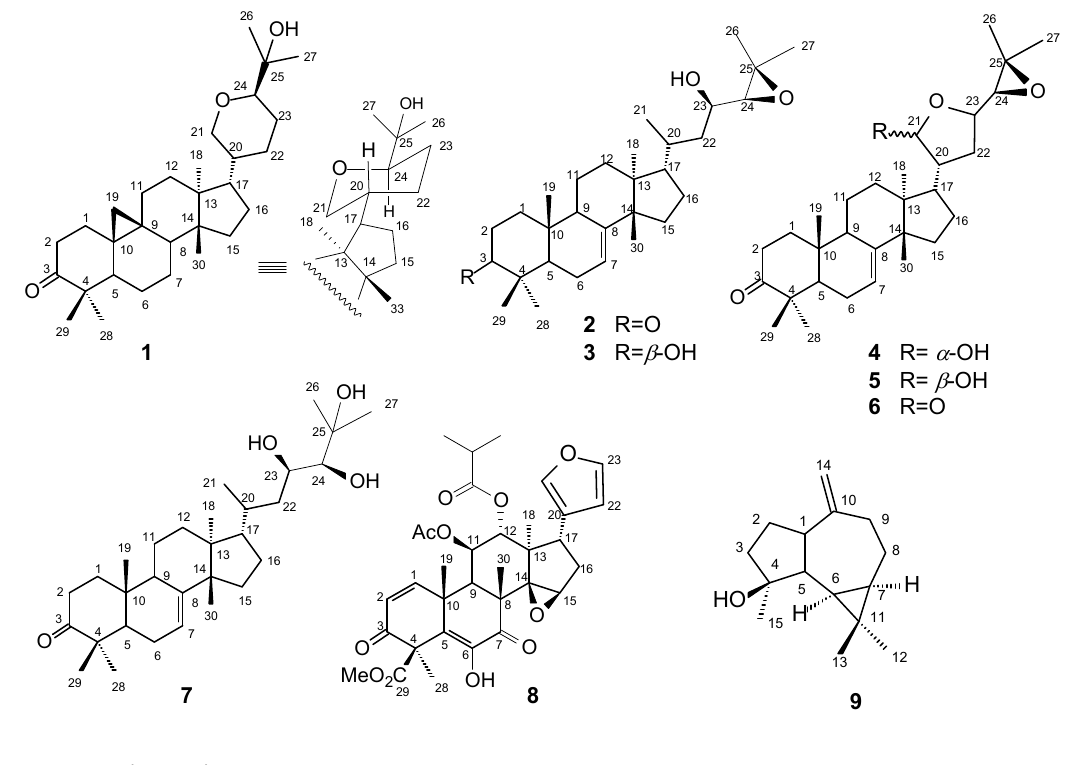
Figure 1. Chemical structure of the compounds isolated from the fruits of T. hirta